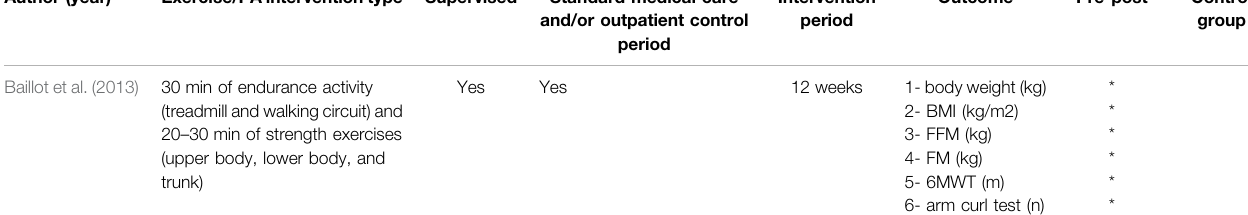
TABLE 3 | Pre- vs. postoperative body composition, weight loss, physical activity level, performance, and metabolic parameters. Author (year) Exercise/PA intervention type Supervised Standard medical care Baillot et al. (2013) 30 min of endurance activity (treadmilland walking circuit) and 20 – 30 min of strength exercises (upper body, lower body,